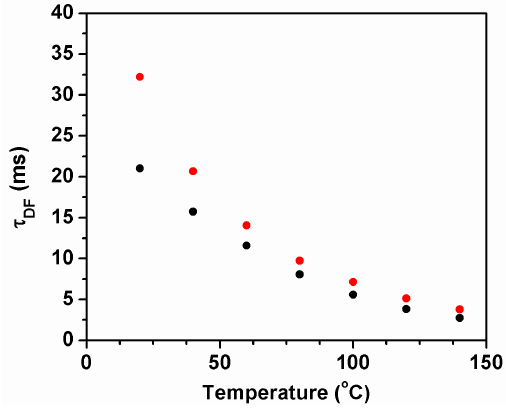
Figure 5. τ DF versus temperature for 12 C 70 (black dots) and 13 C 70 (red dots) in DHOC4.